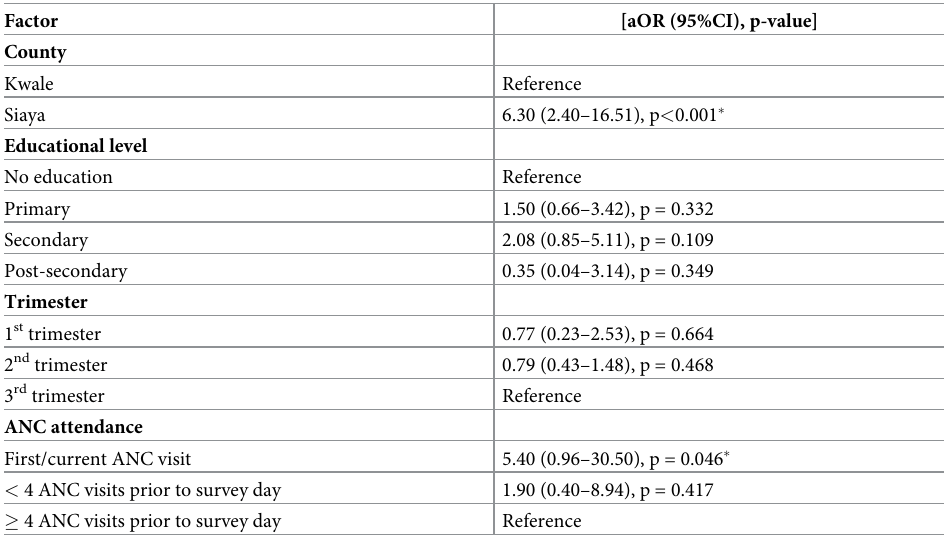
Table 4. Multivariable analysis of factors associated with malaria infection (as measured using PCR technique) in pregnant women in Kwale and Siaya counties,